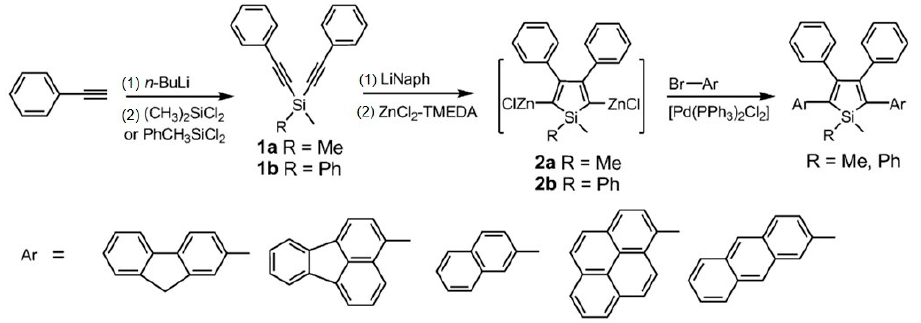
Figure 3. Synthetic routes to the siloles containing planar fluorescent chromophores. TMEDA= N,N,N’,N’-tetramethylethylenediamine [33] . Copyright 2014, Wiley publishing.